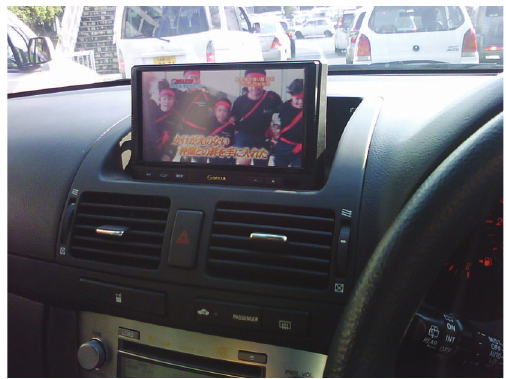
Figure 16: 2CD mode mobile TV reception